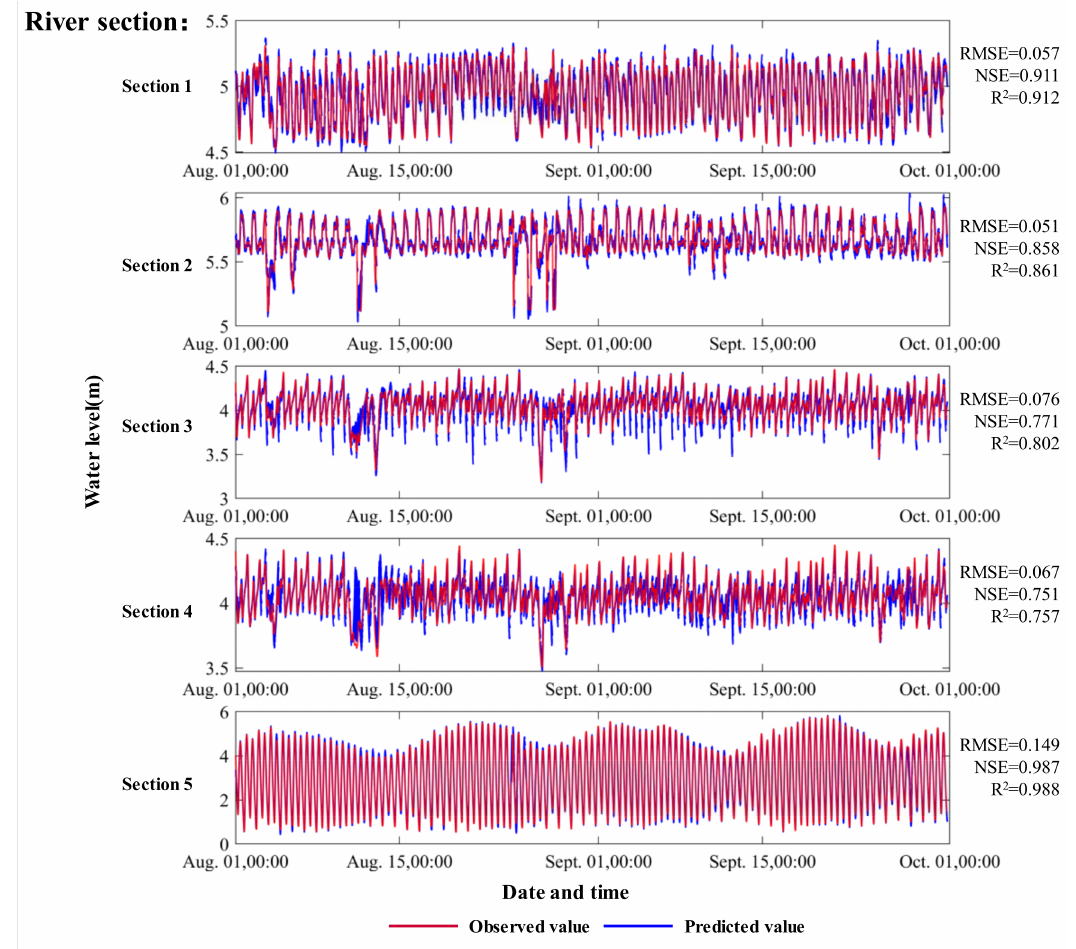
Figure 4. Comparison of observed and simulated water